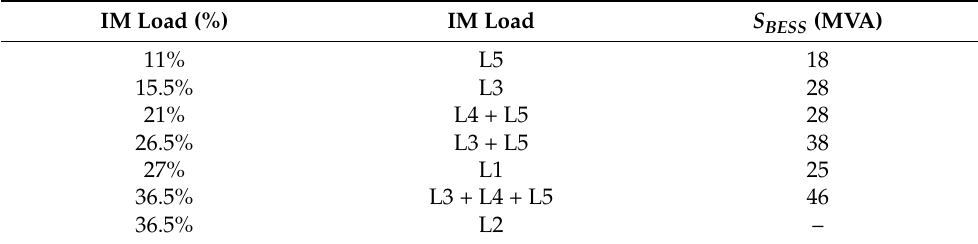
Table 3. Grid-forming BESS power converter sizing vs. IM load percentage.